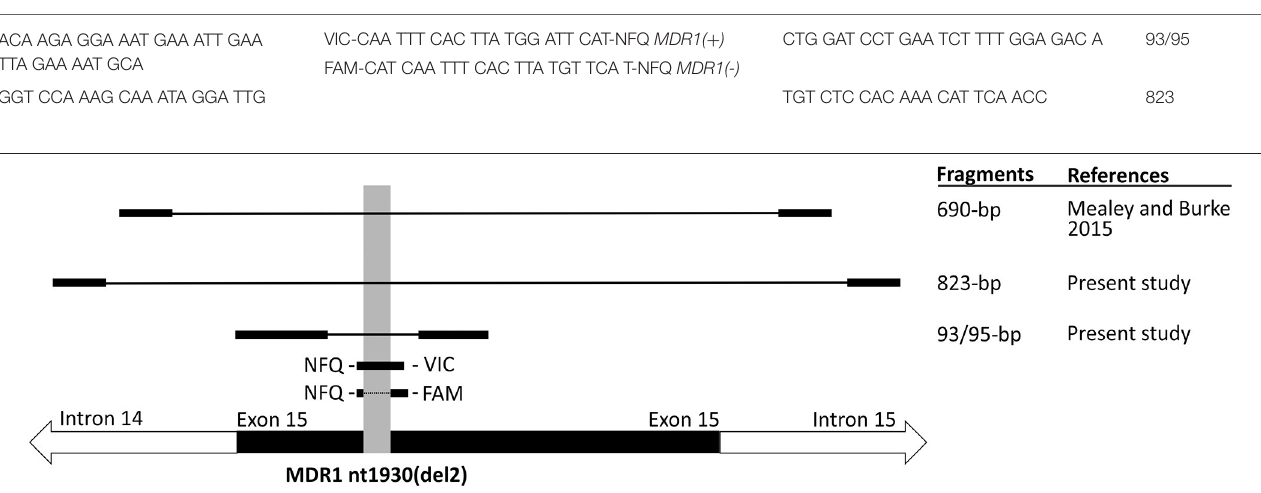
TABLE 1 | Primer and probe sequences used for cat MDR1 PCR amplification and genotyping. Forward primer (5’ → 3’)